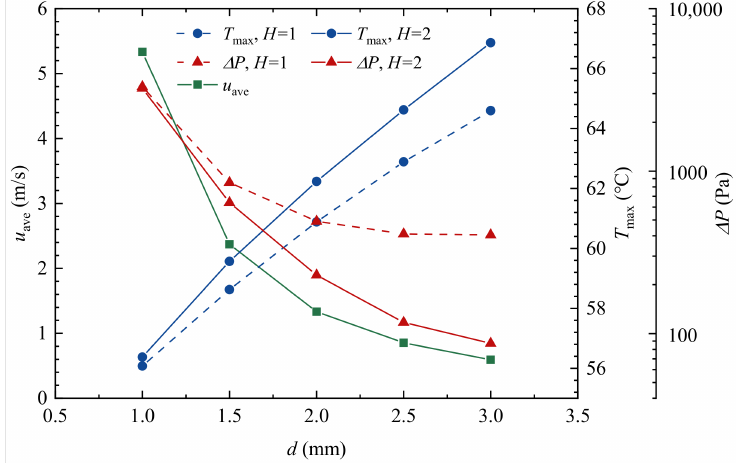
Figure 6. The relationship between u ave , T max , ∆ P and d when H = 1 mm, 2 mm.